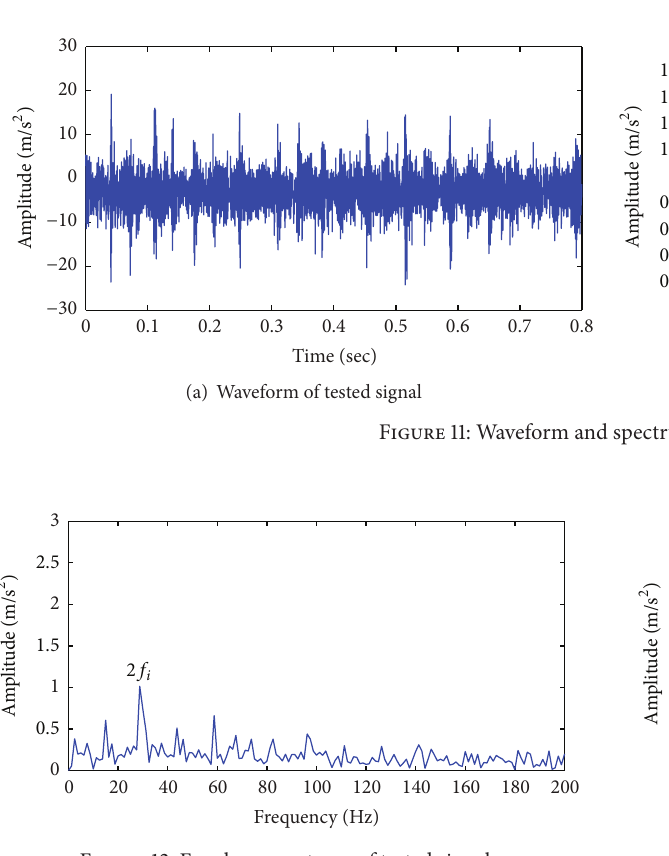
Figure 14: The waveform of the signal after noise